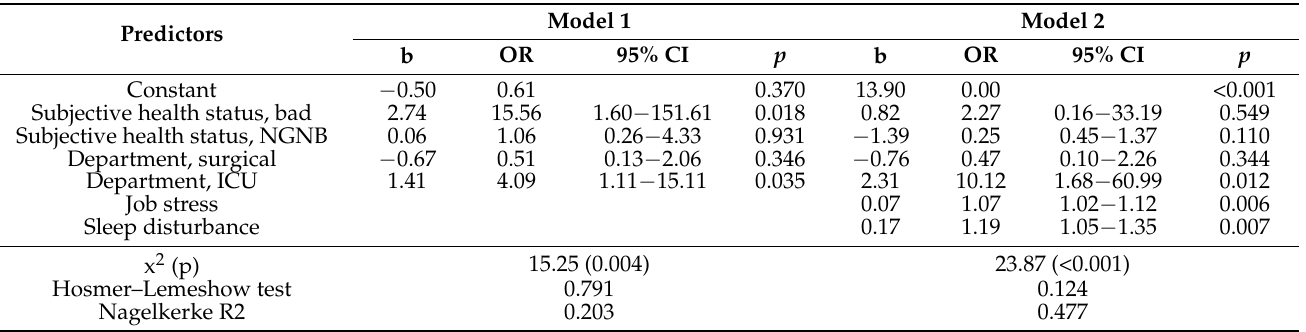
Table 3. Predictors of turnover intention among new graduate nurses working at a tertiary hospital ( N =